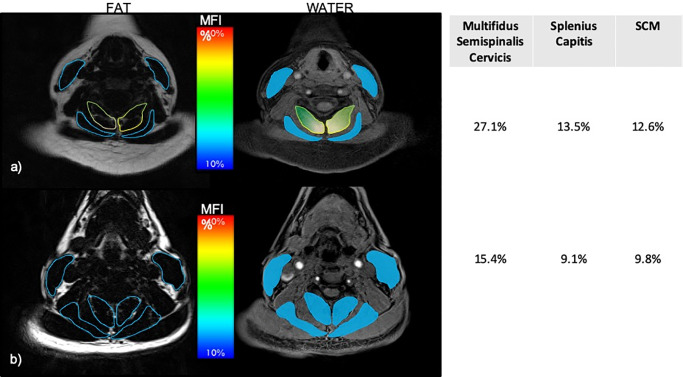
Fat/water MRI of the deep and superficial neck muscles at C5 within one-week of the MVC.a) represents the 32-year-old female with poor recovery at 12-months post-MVC with corresponding MFI values (%). b) represents the 50-year-old male reporting full-recovery at 12-months post-MVC with corresponding MFI values (%).